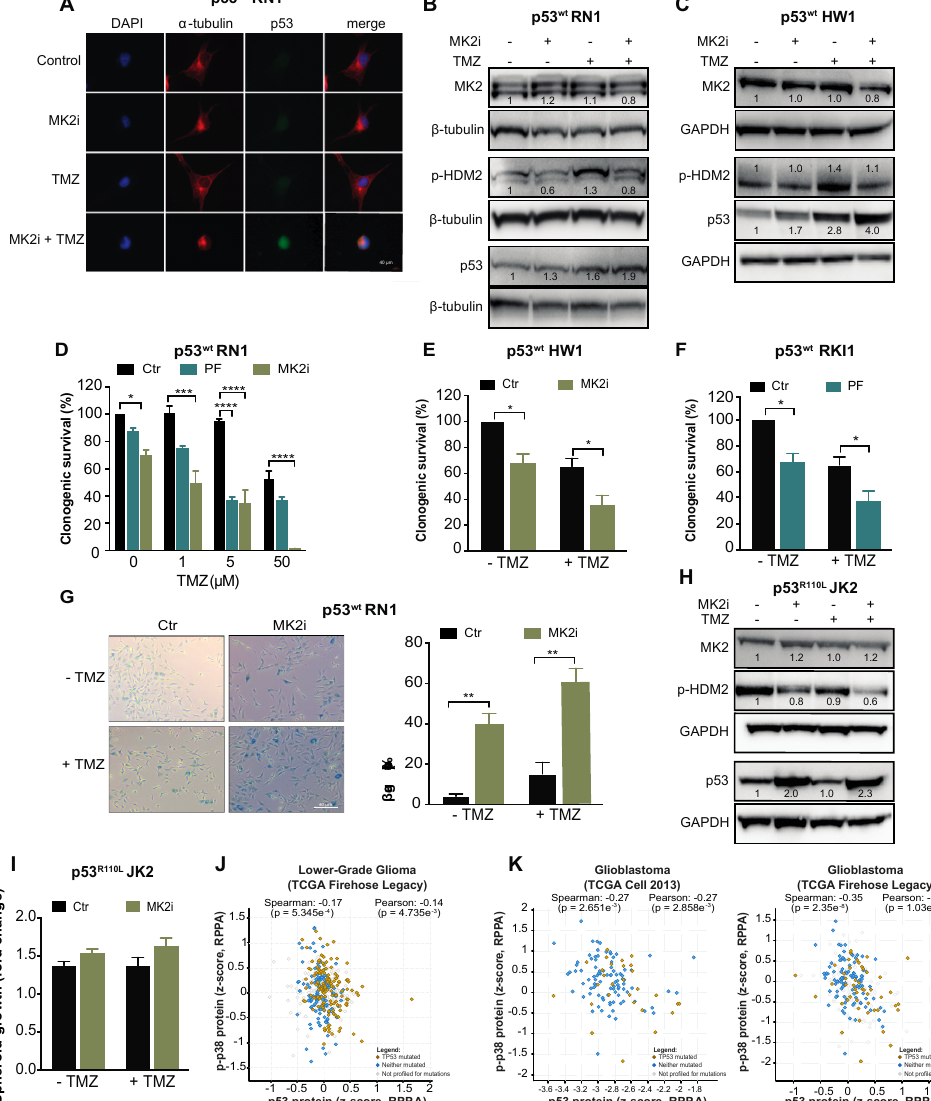
Figure 6. MK2 inhibitors attenuate proliferation of p53 wt glioblastoma stem-like cells. ( A ) Cells were treated with MK2 inhibitor IV (MK2i, 1.5 μ M) and temozolomide (TMZ, 50 μ M) for 48 hr and fixed cells stained with indicated antibodies and DAPI. ( B,C ) Cells were treated with MK2i (1.5 μ M) and temozolomide (50 μ M) for 48 h and lysates immunoblotted against indicated antibodies. ( D–F ) Cells were treated with MK2 inhibitor IV (1.5 μ M), PF-3644022 (PF, 3 μ M) and temozolomide for 12 days and colonies quantified using ImageJ. ( G ) Cells were treated with MK2 inhibitor IV (1.5 μ M) and temozolomide (25 μ M) for 10 days and stained for β -galactosidase ( β -gal). ( H ) JK2 cells were treated with MK2 inhibitor IV (1.5 μ M) and temozolomide (50 μ M) for 48 h and lysates immunoblotted against indicated antibodies. ( I ) JK2 spheroids were treated with temozolomide and growth calculated as the spheroid size on Day 16 over Day 2 (treatment day). ( J,K ) Correlations of p-p38 MAPK and p53 protein expression in the TCGA cohorts of lower-grade glioma (n = 435) and glioblastoma (n = 214 for Cell 2013, n = 244 for Firehose Legacy; cbioportal.org). All immunoblot, immunofluorescence and microscopic images are representatives of 3 independent experiments. Bar graphs for clonogenic and spheroid growth assays are mean ± SEM from 3 independent experiments performed in duplicate (* p < 0.05; ** p < 0.01; **** p < 0.0001; one-way ANOVA followed by Bonferroni’s posttest for multiple comparison in D and paired t-test in E,F,G).